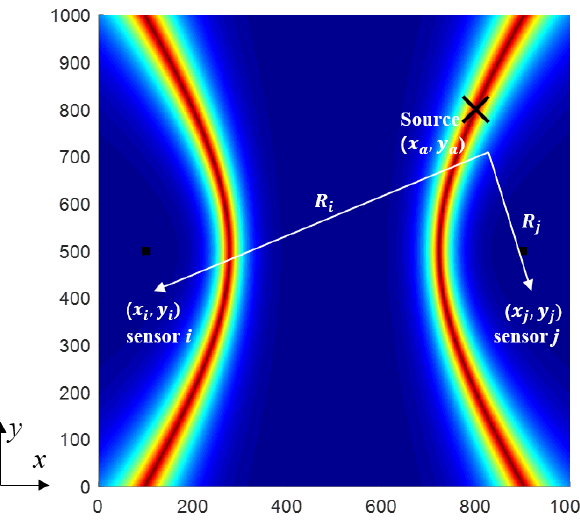
Figure 2. A schematic to describe the impact localization using the probabilistic hyperbola